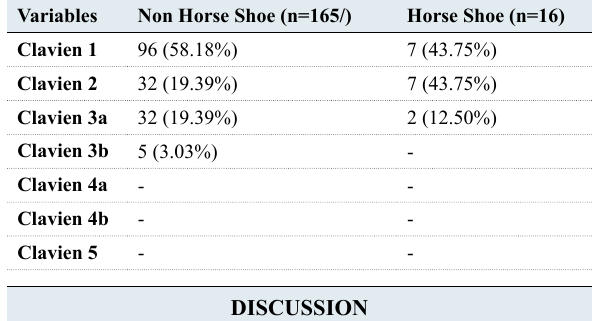
Table 4: Description of complications among the study population